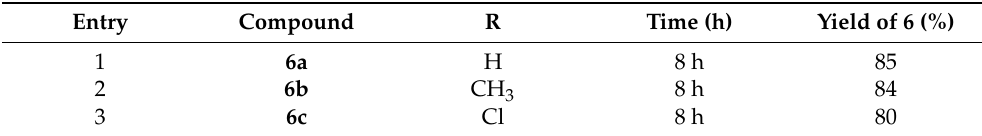
Molecules 2022 , 27 , x